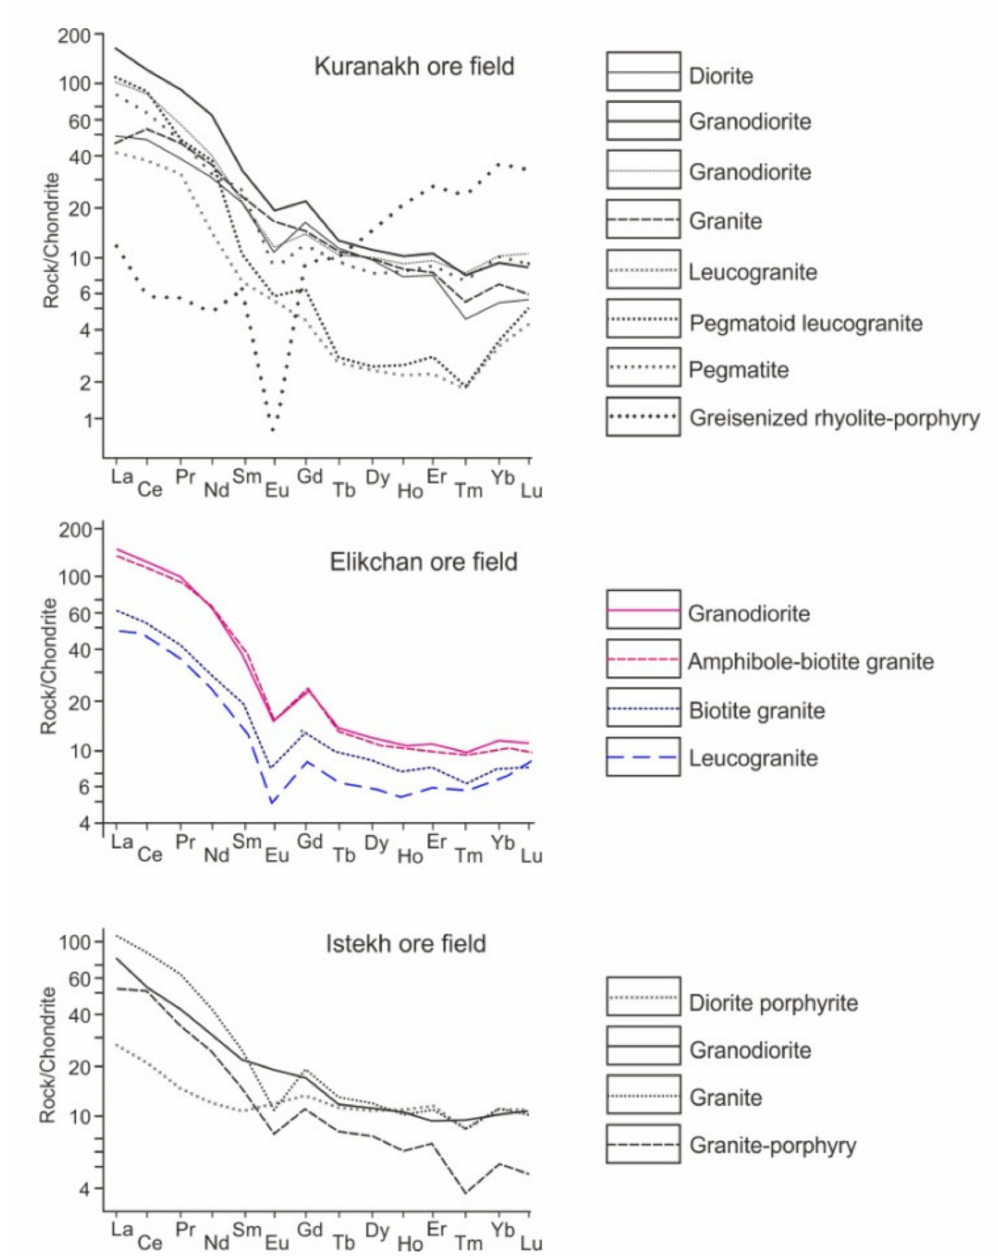
Figure 10. Chondrite-normalized [80] rare-earth element (REE) patterns of magmatic rocks within the Kuranakh, Elikchan, and Istekh ore